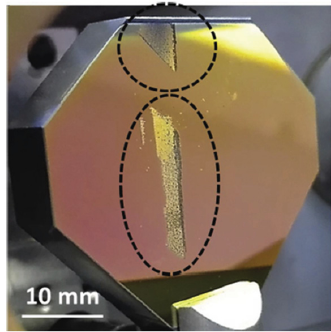
Figure 2. The damage to the optical mirror. Reproduced with permission from [39], Elsevier, 2019.